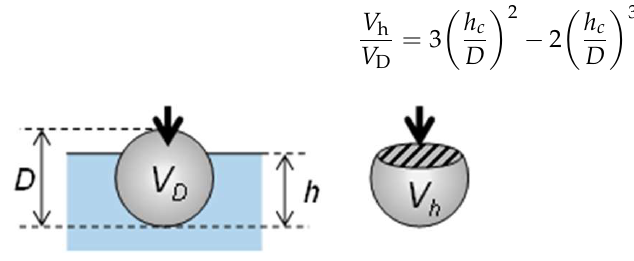
Figure 13. Schematic illustration of particle embedment.